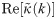
The influence of burst duration on pattern formation.
A. Examples of synaptic strength evolution over time. Numbers along the top indicate the input burst duration in seconds. B. Mean power spectra, normalized by the peak power in each spectrum, of the final connectivity patterns in simulations using burst durations of 0.03 s (blue), 0.3 s (orange), and 3.0 s (black). C. Robustness of the periodic connectivity pattern to different burst durations. Reference power spectra are taken from simulations with a burst duration of 0.1 s. Black: robustness measures for each burst duration. Pink: theoretical robustness measure, based on the concentration of power at k* in Re[κ~(k)], normalized to the theoretical robustness for a burst duration of 0.1 s. D. Examples of Re[κ~(k)] for burst durations of 0.03 s (blue), 0.3 s (orange) and 3.0 s (black). The negative lobe in the black curve extends beyond the horizontal axis and has been cut for clarity. E. Spatial frequencies of connectivity patterns that developed in simulations as a function of the burst duration (black circles and error bars: mean ± SEM). Grey line: predicted spatial frequencies. The sawtooth fluctuations at longer burst durations correspond to the emergence of new dominant peaks in κ~(k), which is compressed towards lower spatial frequencies as the burst duration is increased. F. Theoretical robustness as a function of burst duration for asymmetric STDP rules with τ
+ = 20 ms (pink) and τ
+ = 50 ms (green).